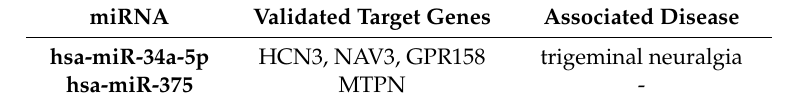
Table 2. Validated target genes linked to pain-migraine of hsa-miR-34a-5p according to the DIANA- TOOLS database. Validated target genes linked to exocytosis of hsa-miR-375 according to the DIANA- TOOLS database.